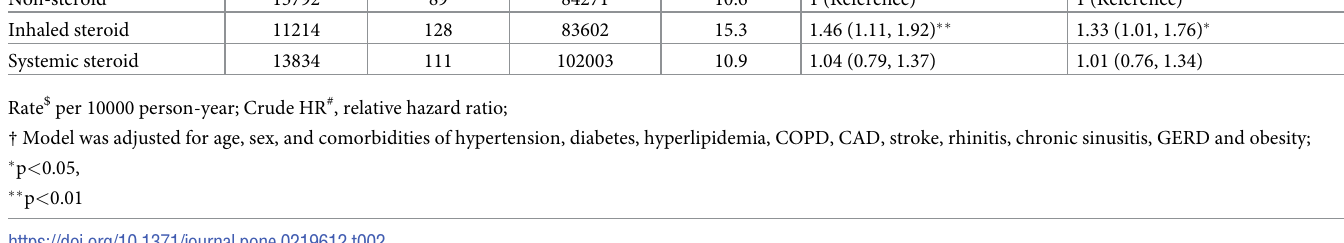
There is an error in the Table 5 footnotes: “Rate $ per 1000 person-year” should appear as “Rate $ per 10000 person-year.” Table 5. Cox proportional hazards regression analysis measured hazard ratio of obstructive sleep apnea among asthma patients by different treatments. Variables N Non-steroid Inhaled steroid Systemic steroid Rate $ per 10000 person-year; Crude HR # , relative hazard ratio; † Model was adjusted for age, sex, and comorbidities of hypertension, diabetes, hyperlipidemia, COPD, CAD, stroke, rhinitis, chronic sinusitis, GERD and obesity; � p < 0.05, �� p <